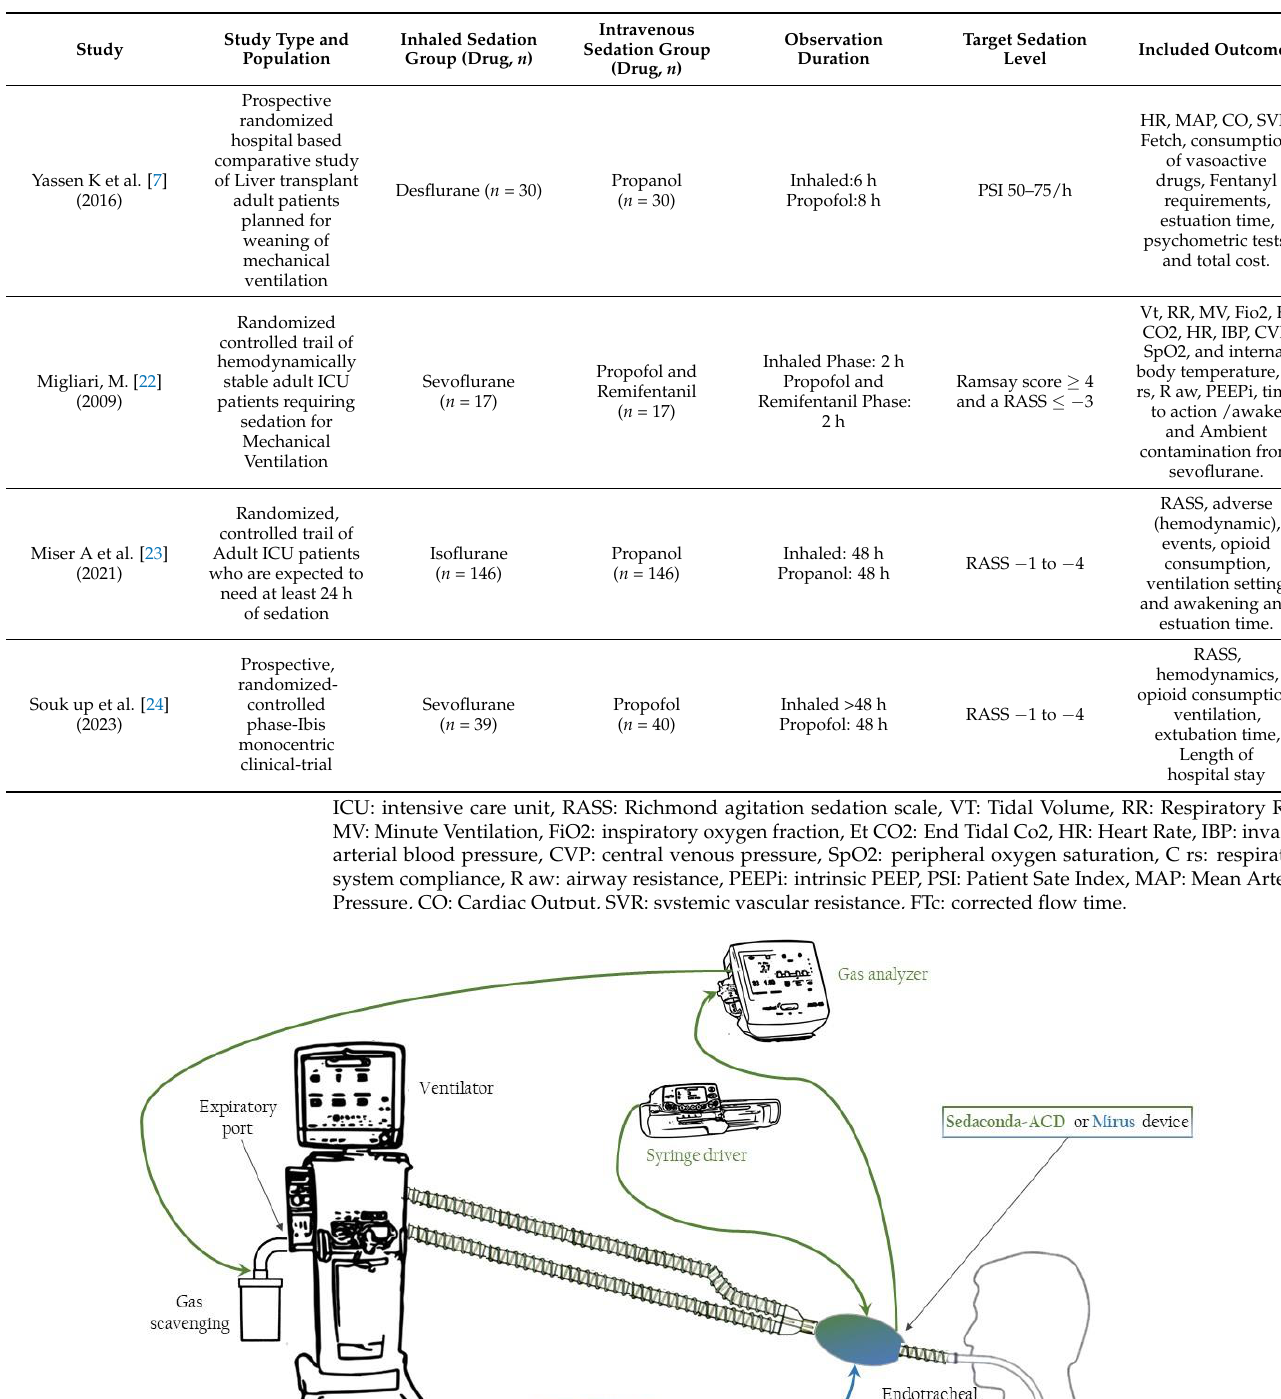
Table 3. Published randomized controlled trials in a chronological order demonstrating the inhaled sedation preserving effect on the hemodynamics as compared to intravenous propofol sedation.